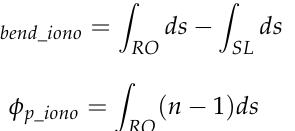
Figure 1. ( a ) GNSS-RO excess phase φ iono _ free profile from COSMIC-1 superimposed by the neutral atmospheric bending φ atm (in red) component derived from fitting the data h t = 30–60 km; ( b ) Il- lustration of different excess phase components in GNSS-RO for L1 excess phase φ exL 1 , L2 excess phase φ exL 2 , atmospheric bending φ atm , ionospheric component ( φ ex _ iono = φ ex − φ atm ) for L 1 and L 2, F -region contributions φ bend _ F − φ p _ F , and D/E -region phase advance − φ p _ D / E . A thin sporadic- E ( E s ) layer is identified at 107 km with an enhanced excess phase in both − φ exL 1 and − φ exL 2 data. This is because bending delay (due to a longer pathlength) and phase advance (due to faster phase speed) in the ionosphere produce the opposite effects in the measured excess phase φ ex . These components are defined